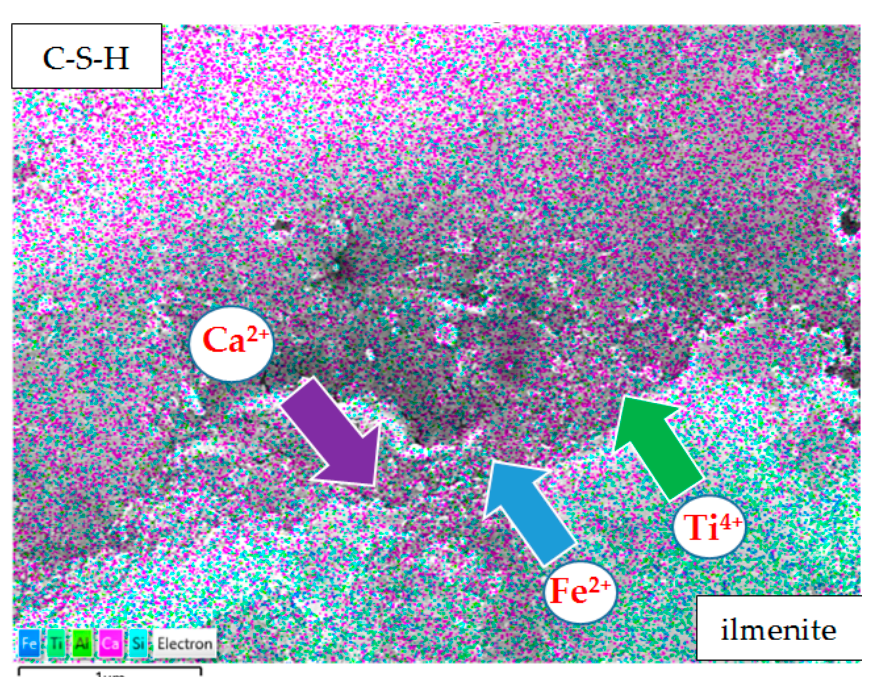
Figure 7. BSE image of concrete.